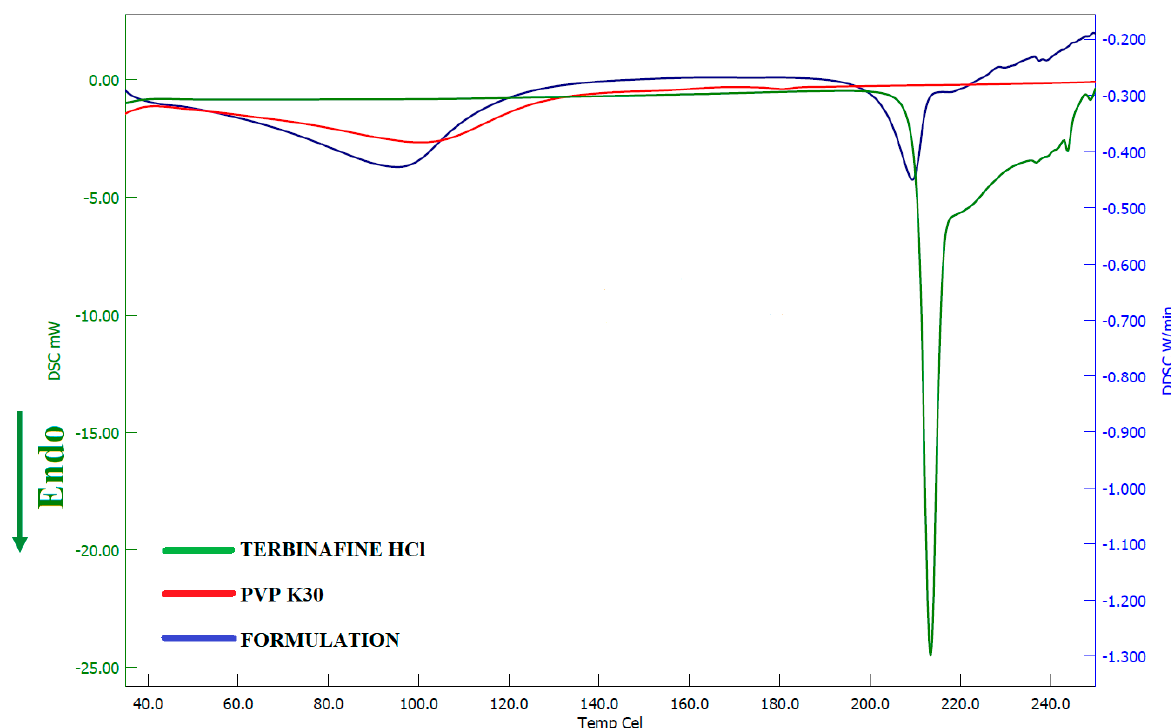
Figure 9. Differential scanning calorimetric patterns of terbinafine, polyvinylpyrrolidone K 30, and optimized batch (F8).